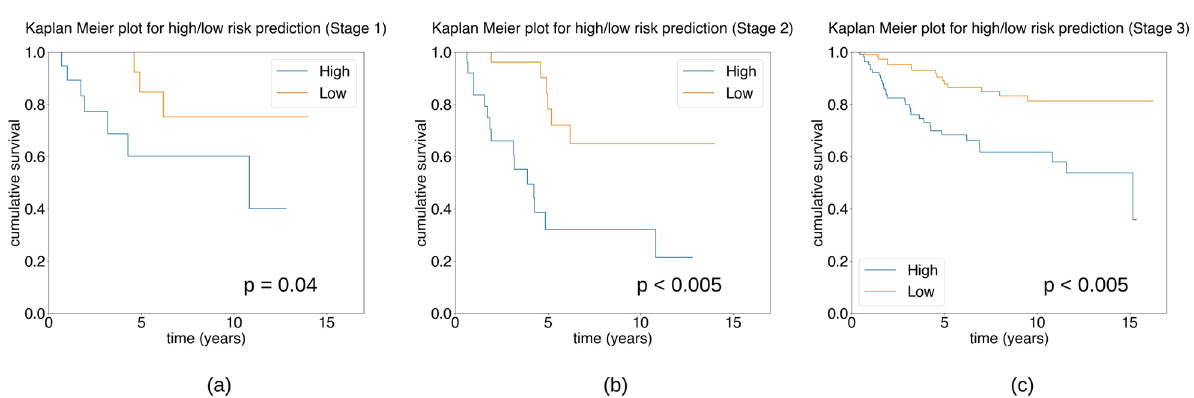
Figure 4. Kaplan–Meier survival estimation for three stages of analysis using the deep learning model (Model 1) output for disease-specific survival in TNBC. The plots show the results of using ( a ) only the test data (Stage 1), ( b ) test and validation data (Stage 2), and ( c ) the whole dataset of TNBC patients (Stage